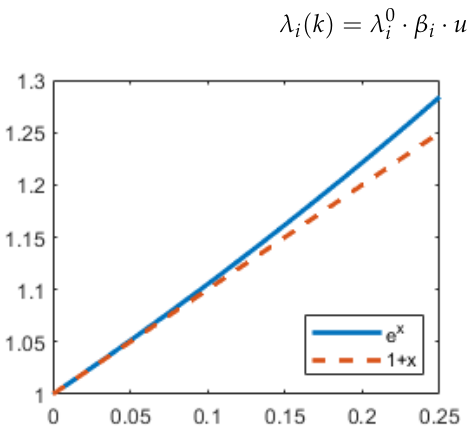
Figure 3. Approximation